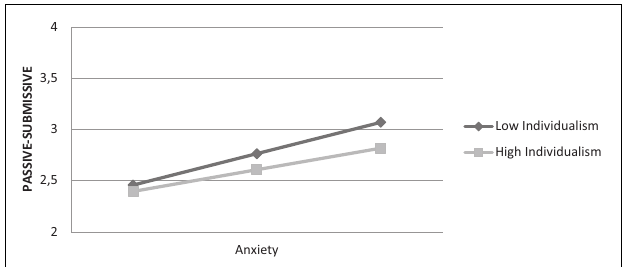
TABLE 3 | Predictors of coping styles.